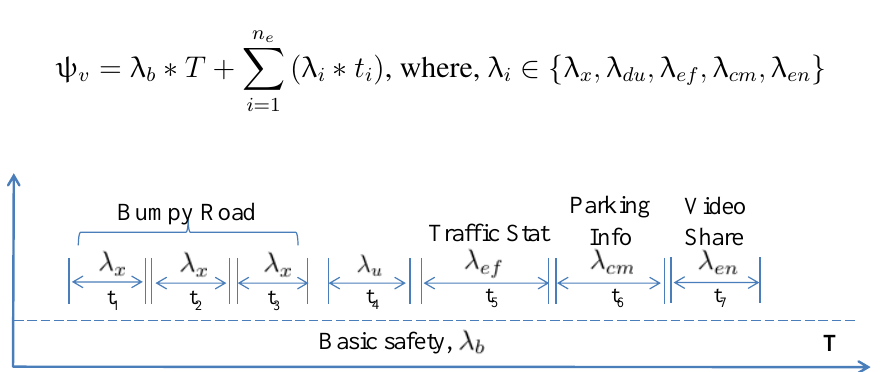
Figure 4. An example timeline of vehicle storage, ψ